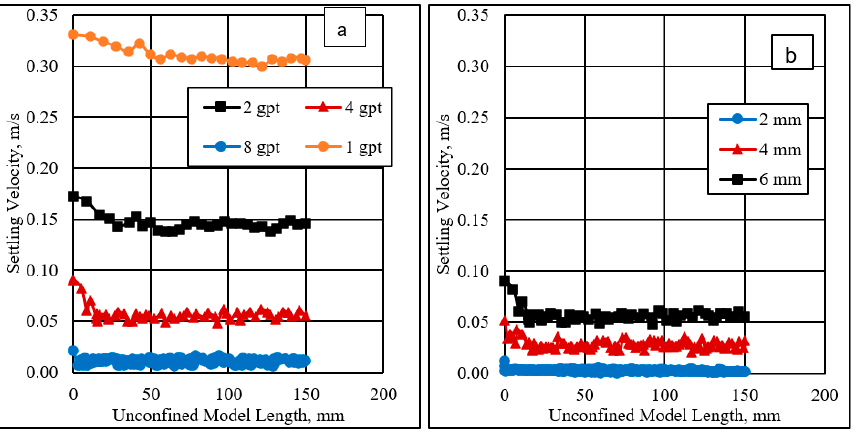
9 of 19 Figure 8. Loss factor (G ″ /G ′ ) of the HVFR. 4. Results and Analysis of the Spherical Particles Settling The spherical particles settling velocity in creep regimes was measured using two fracture models: unconfined and confined fracture systems.